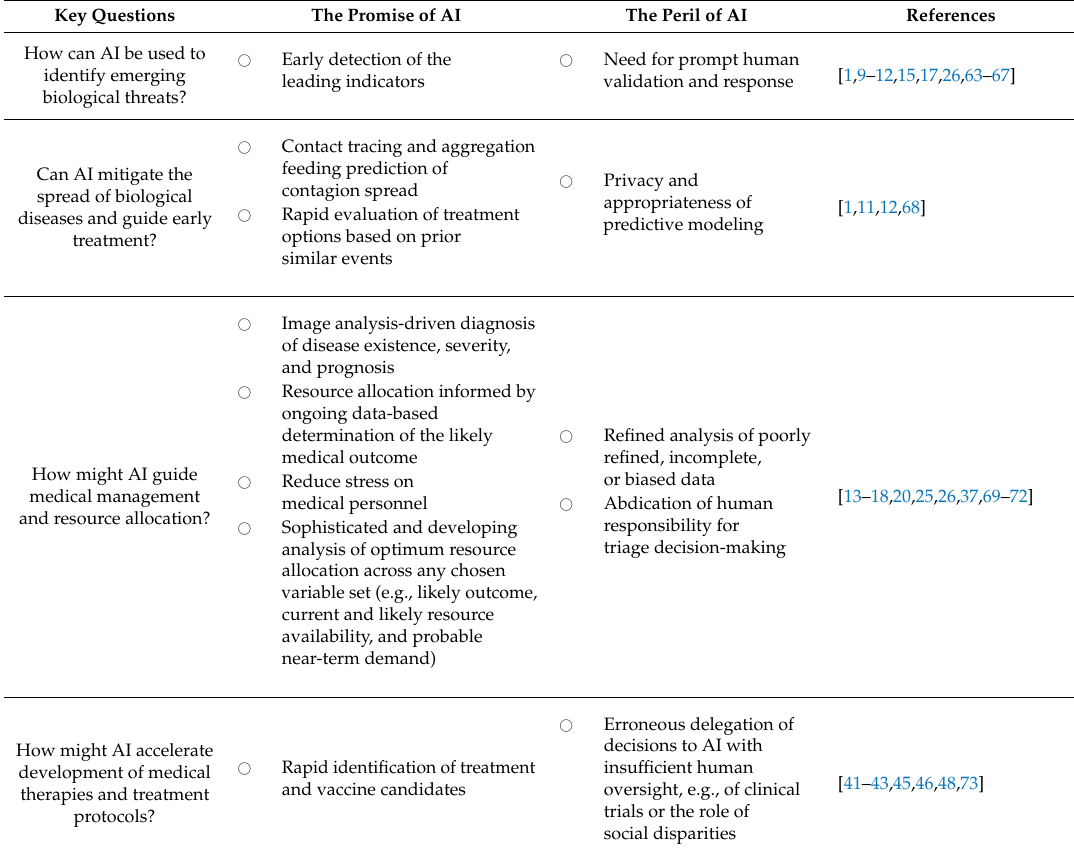
Table 1. The promise and peril of using AI in